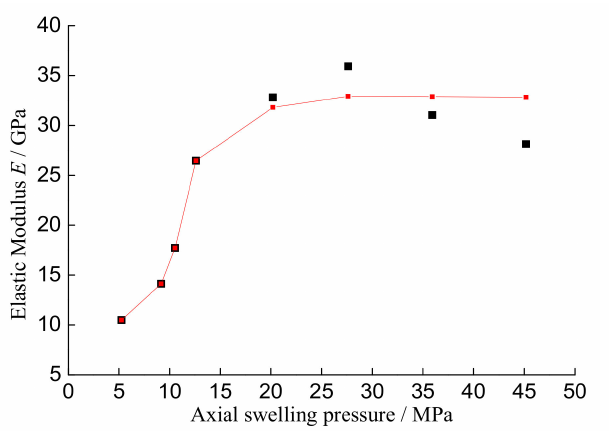
Figure 7. Variation of elastic modulus with axial pressure.